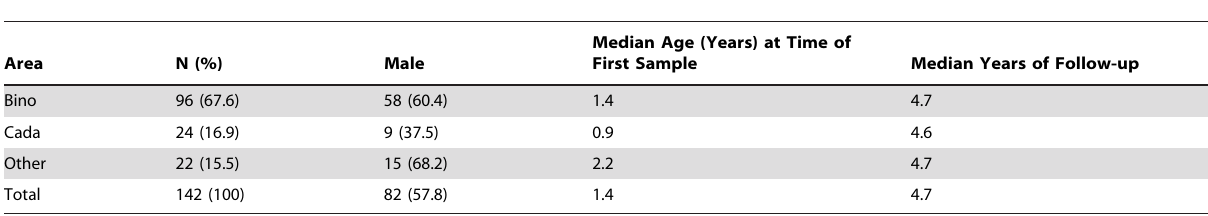
Table 1. Characteristics of the Study Population.